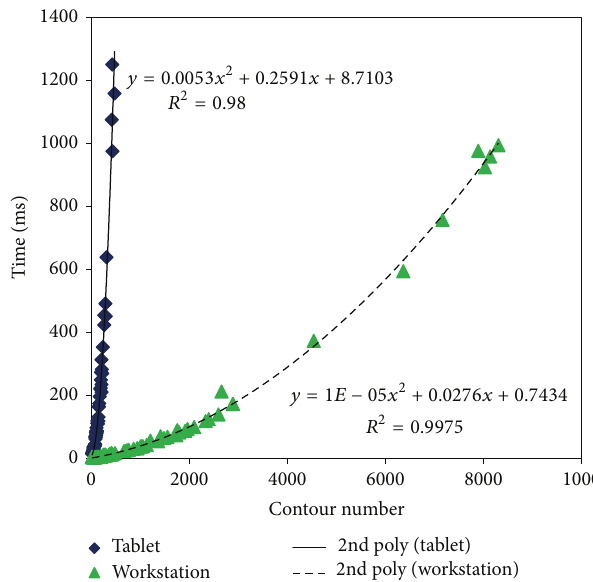
Figure 12: Computational time for contour analysis with different scene